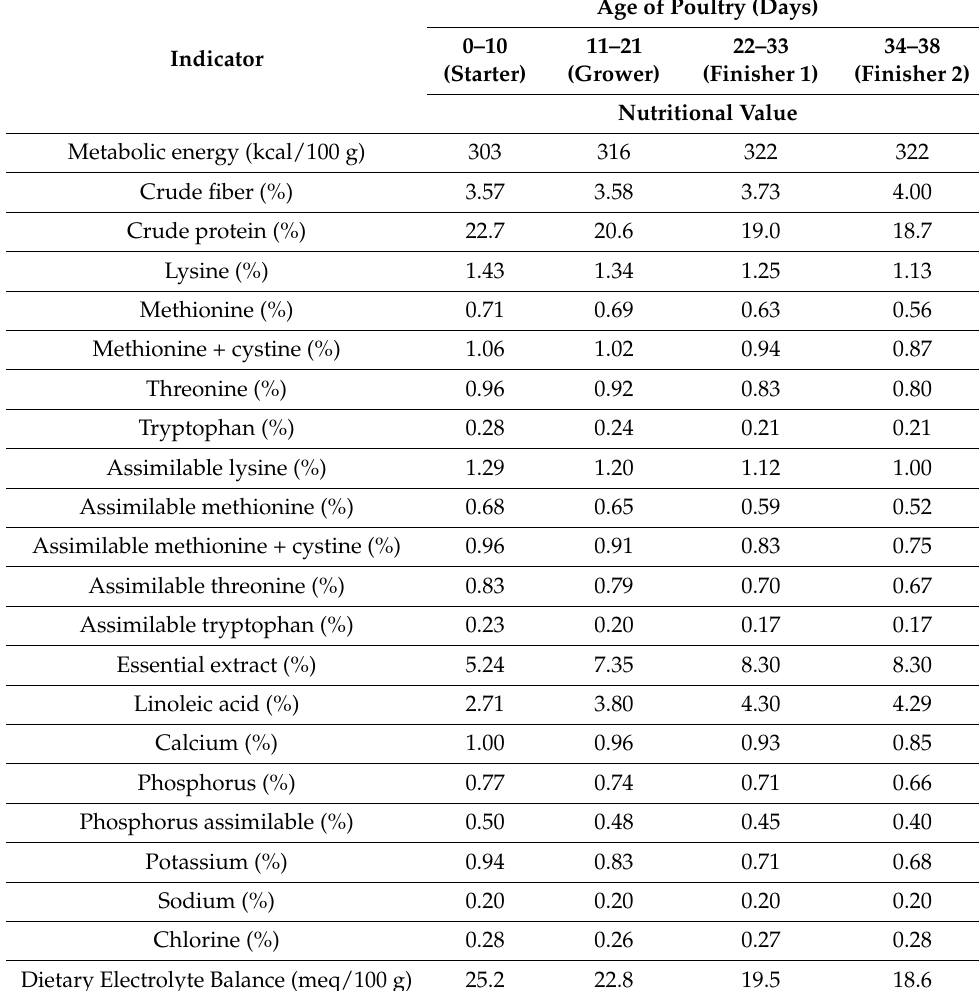
Table 3. Nutritional value of the rations of broiler